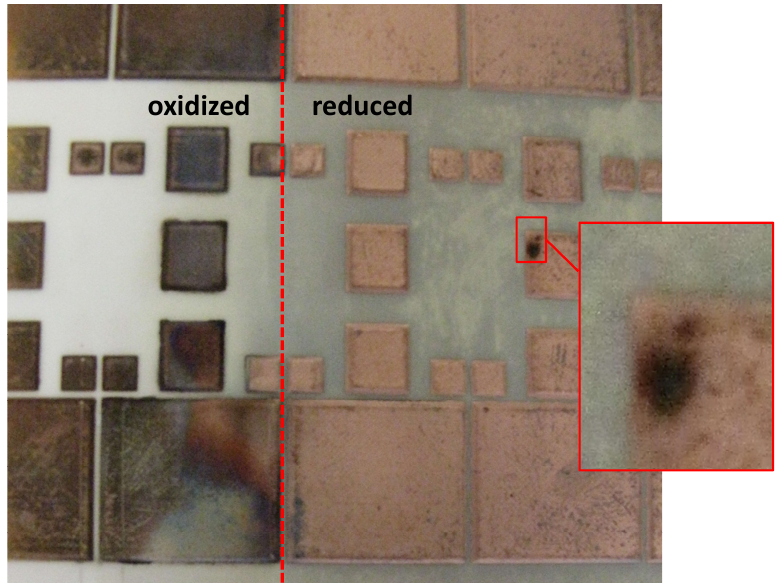
Figure 14. The ceramic board with floating copper electrodes pre-oxidized with air plasma ( left side ) and subsequently partially reduced with forming gas 95/5 plasma ( right side ). The electrodes are grounded by the plasma bridge operated with a gas mixture consisting of 98% argon and 2% hydrogen. In the magnification, the oxidized zone due to the accidental extinguishing of the plasma bridge between contact